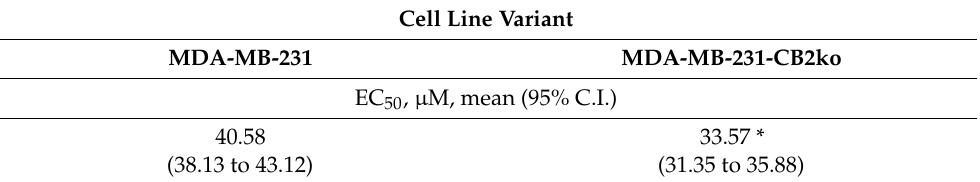
Figure 4. The effect of CB2 receptor knockout on DHA-DA cytotoxicity. Incubation 24 h, MTT test, mean ± standard deviation ( n = 7 experiments). Table 2. The effect of CB2 receptor knockout on DHA-DA cytotoxicity. Incubation 24 h; MTT test. *, a statistically significant difference from the original cell line in the ANOVA test with the Holm– Sidak post ‐ test.